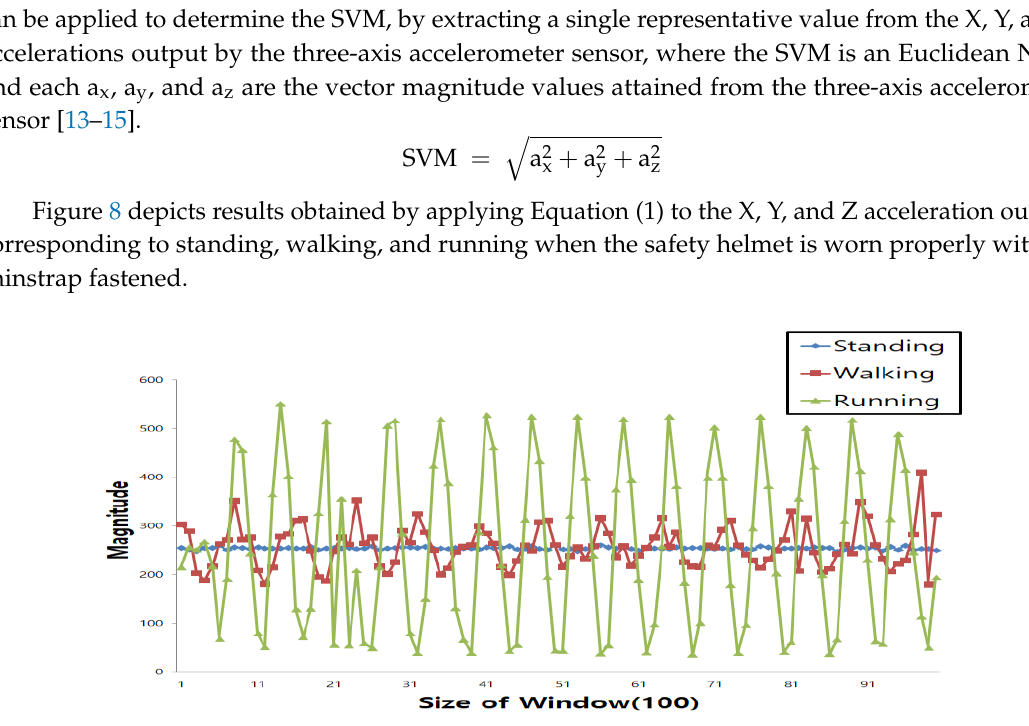
Figure 7. Screenshots of the personal smartphone app for transmitting data.